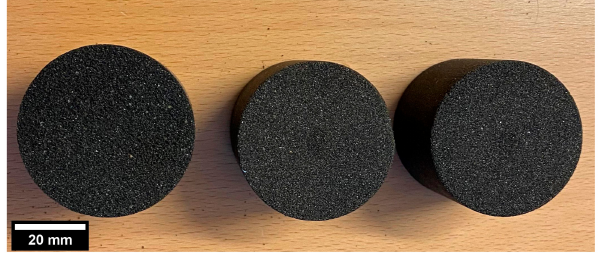
Figure 2. Furan sand samples with varying grain size